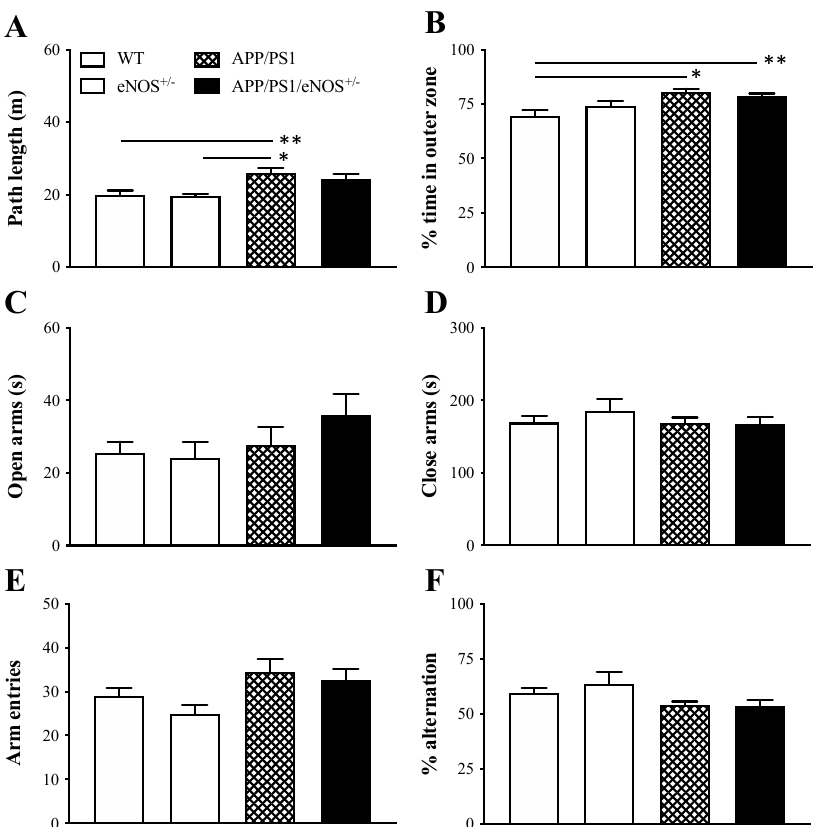
Figure 2. Mean (± SEM) path length ( A ) and % time in the outer zone ( B ) in the open field, time (s) spent in the open arms ( C ) and close arms ( D ) in the elevated plus maze, and the total number of arm entries ( E ) and the percentage of spontaneous alternation ( F ) in the Y-maze in 8-months old wildtype (WT), eNOS +/ − , APP/PS1 and APP/PS1/eNOS +/ − mice ( n = 8–12/genotype). * indicates a sig- nificant difference between groups at * p < 0.05 or ** p < 0.01.